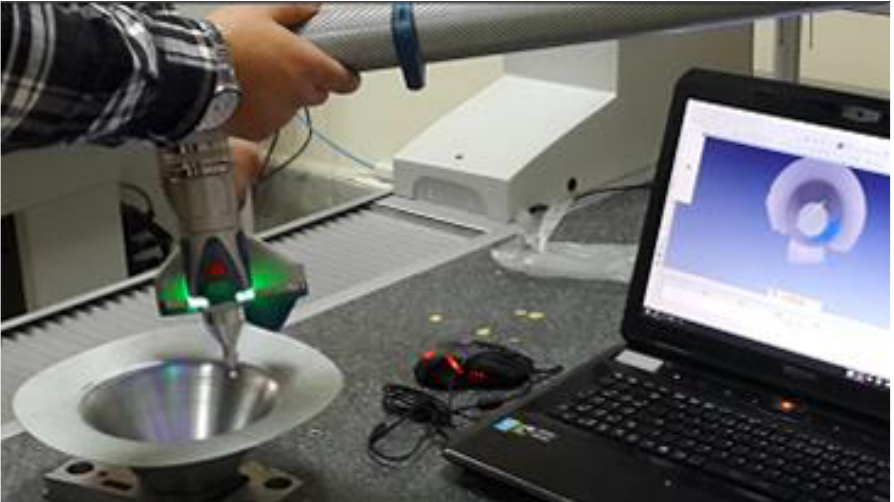
Figure 4. Laser 3D scanner with its associated software.